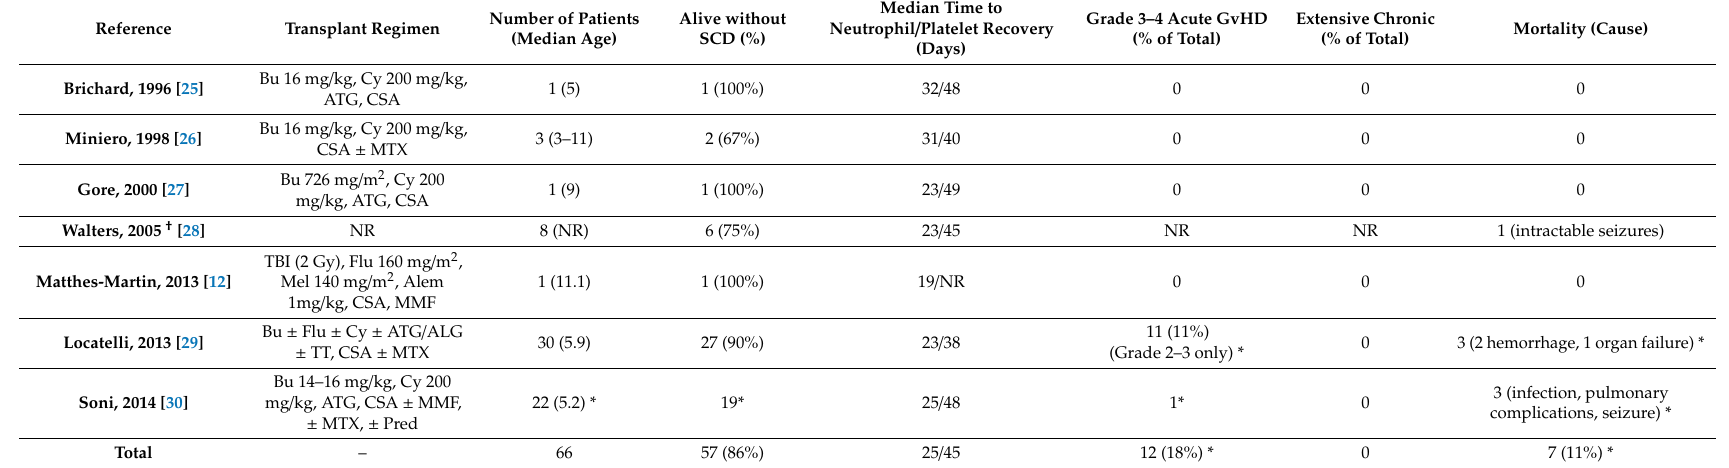
Table 1. Pediatric related umbilical cord transplants for sickle cell disease